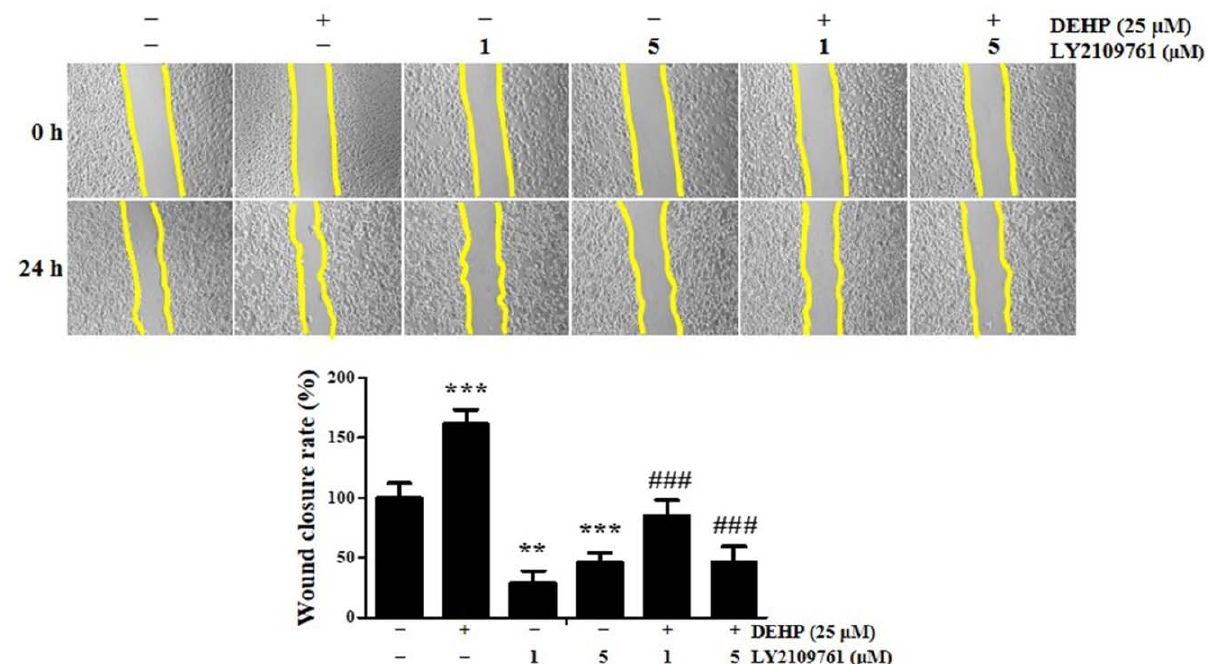
Figure 8. Di-(2-ethylhexyl) phthalate (DEHP)—induced elevated migratory potential of human endometrial epithelial cells. Representative photomicrographs (100 × ) of Ishikawa cells migrating to the cell-free space under a phase contrast microscope. Images were captured at 0 and 24 h. The distances between the two edges are scaled for three positions at different times. All data are expressed as relative values against their respective control group. Data represent the mean ± standard deviation of three independent experiments. ** p < 0.01 and *** p < 0.001 (vs. control); ### p < 0.001 (vs. DEHP treatment).